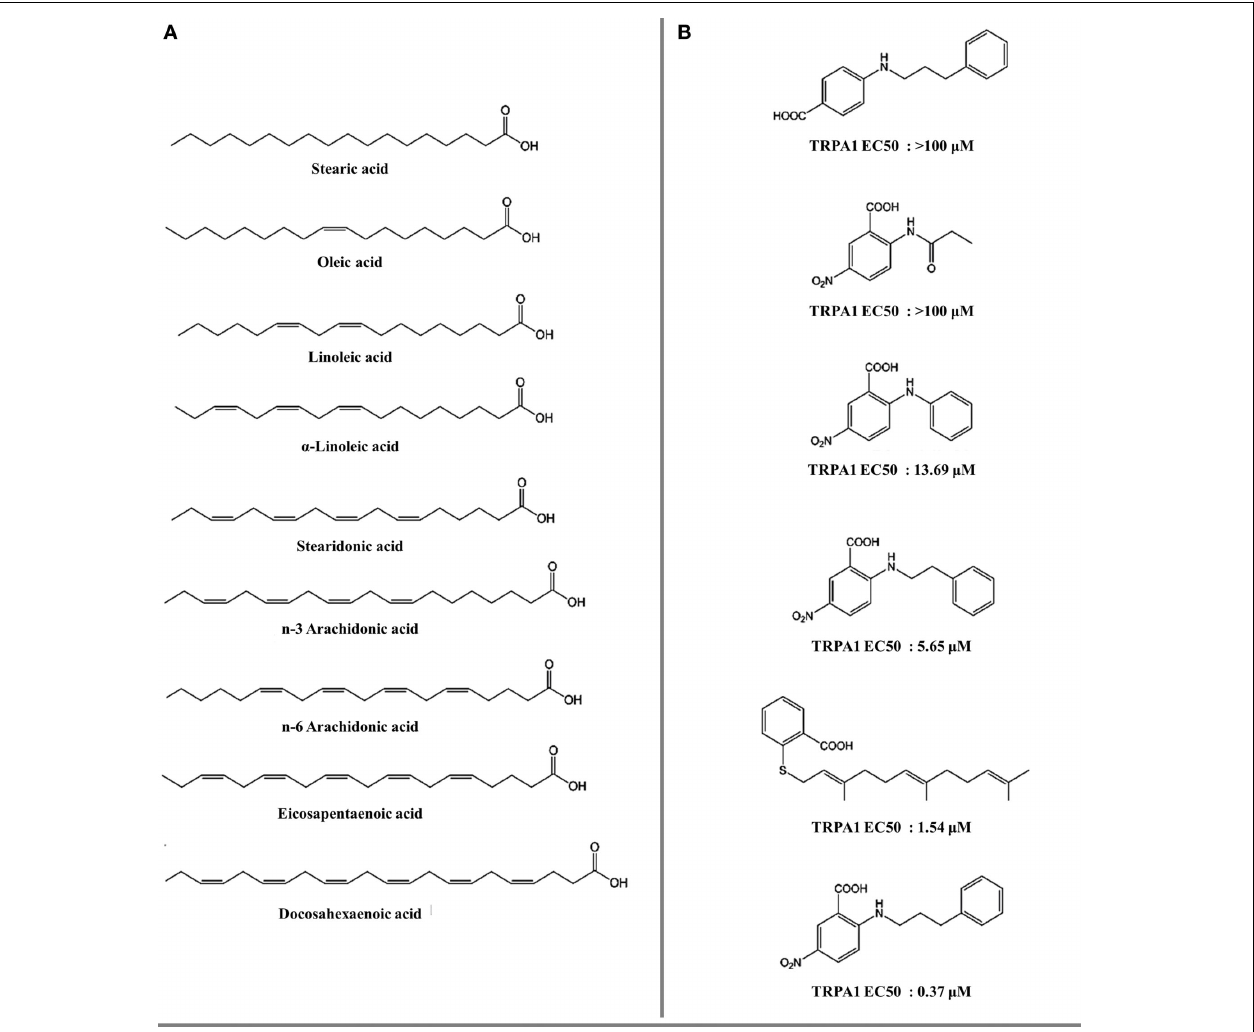
FIGURE 6 | Fatty acids and lipids as thermoTRP channel ligands. (A) Polyunsaturated fatty acids (PUFAs) evaluated on TRPV1 and TRPA1 receptors (Matta et al., 2007; Motter and Ahern, 2012). (B) 5-nitro-2-(3-phenylpropylamino) benzoic acid derivatives evaluated on TRPA1 receptors (Liu et al.,